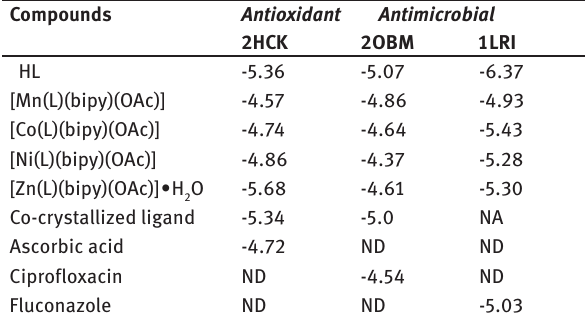
Figure 7: Ferrous chelating data of the ligand.